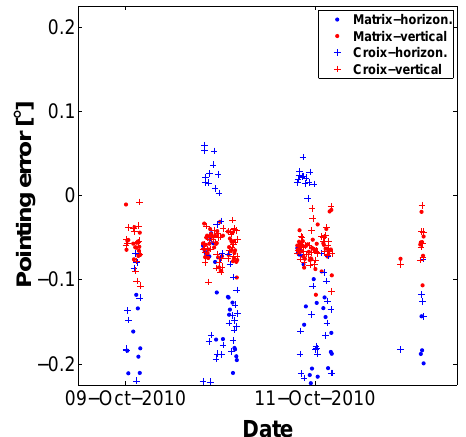
Fig. 9. Estimated center for matrix and cross measurements for photometer #047 .